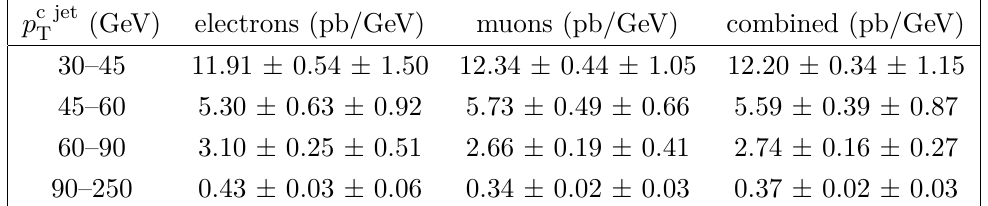
Table 6 . Measured differential cross section as a function of p c jet and combined value. The first and second uncertainty values correspond to the statistical and systematic contributions,